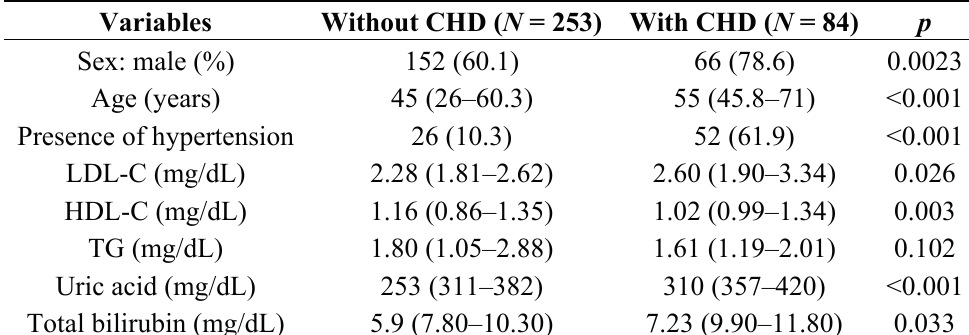
Table 1. Demographics of the study